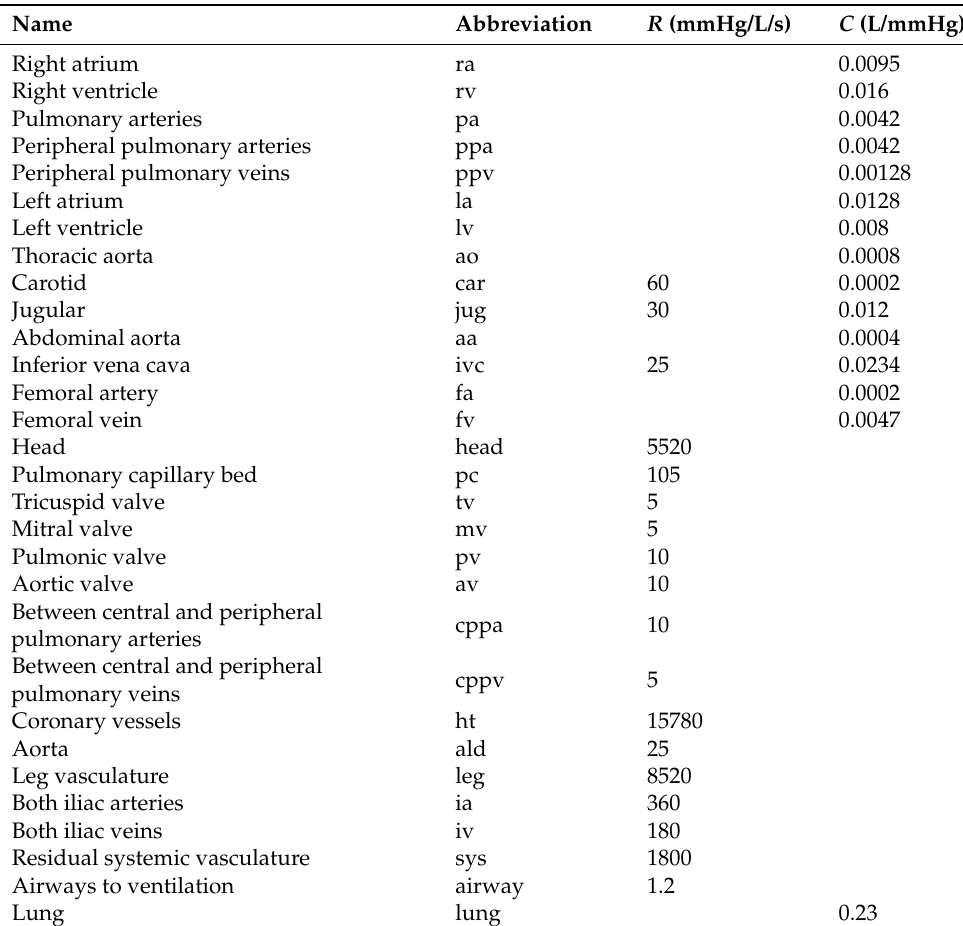
Table A2. Definitions and values of